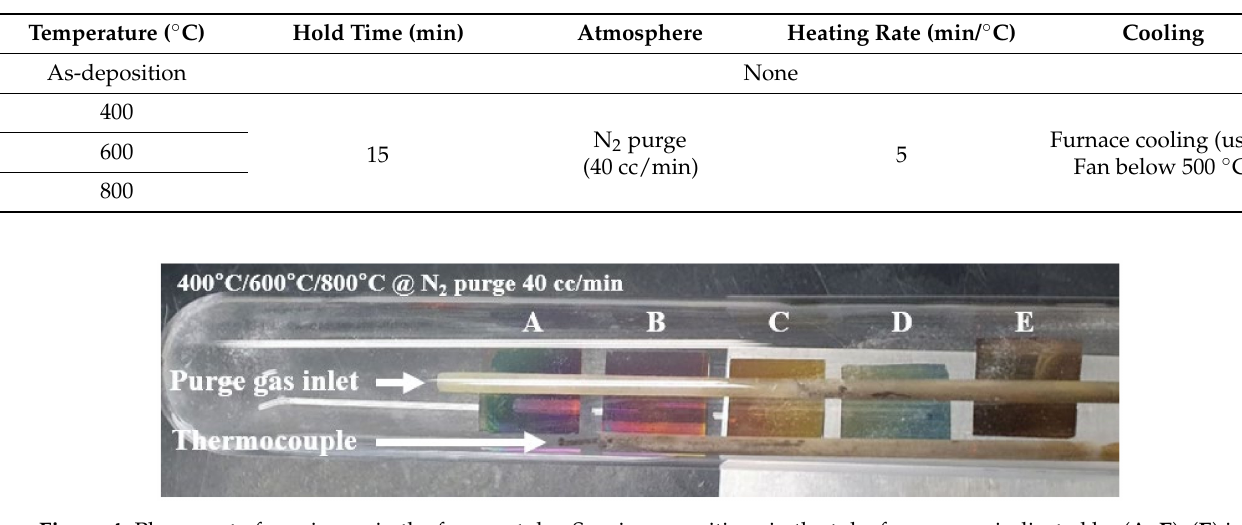
Figure 4. Placement of specimens in the furnace tube. Specimen positions in the tube furnace are indicated by ( A – E ). ( E ) is placed near the cap, and ( A ) is